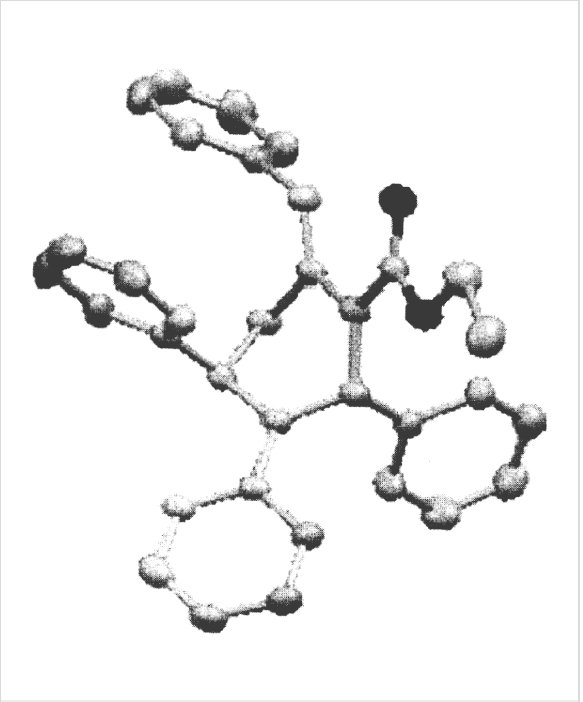
Figure 1: X-ray structure showing the anti orientation of the phenyl rings at C2 and